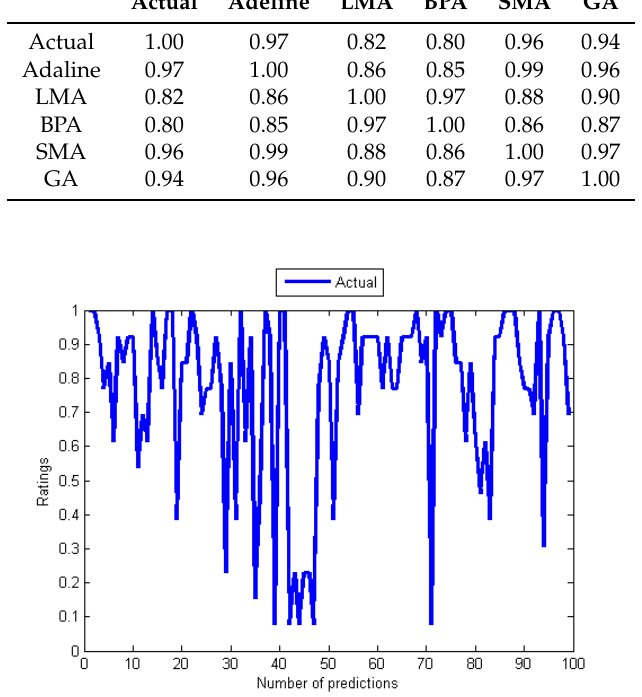
Table 5. Correlations between Experimental results.